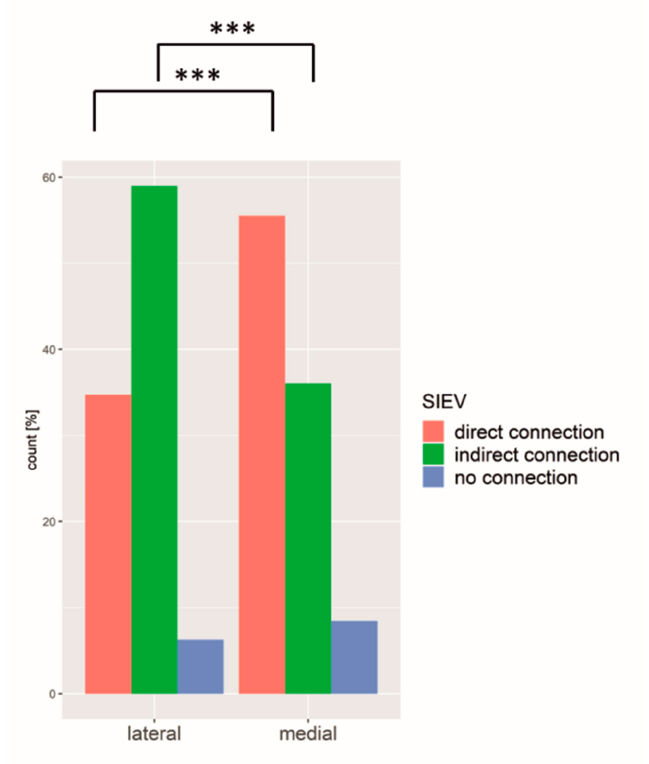
Figure 5. Medial row perforators were more often directly connected to the SIEV compared to lateral perforators. *** = p ≤ 0.001.